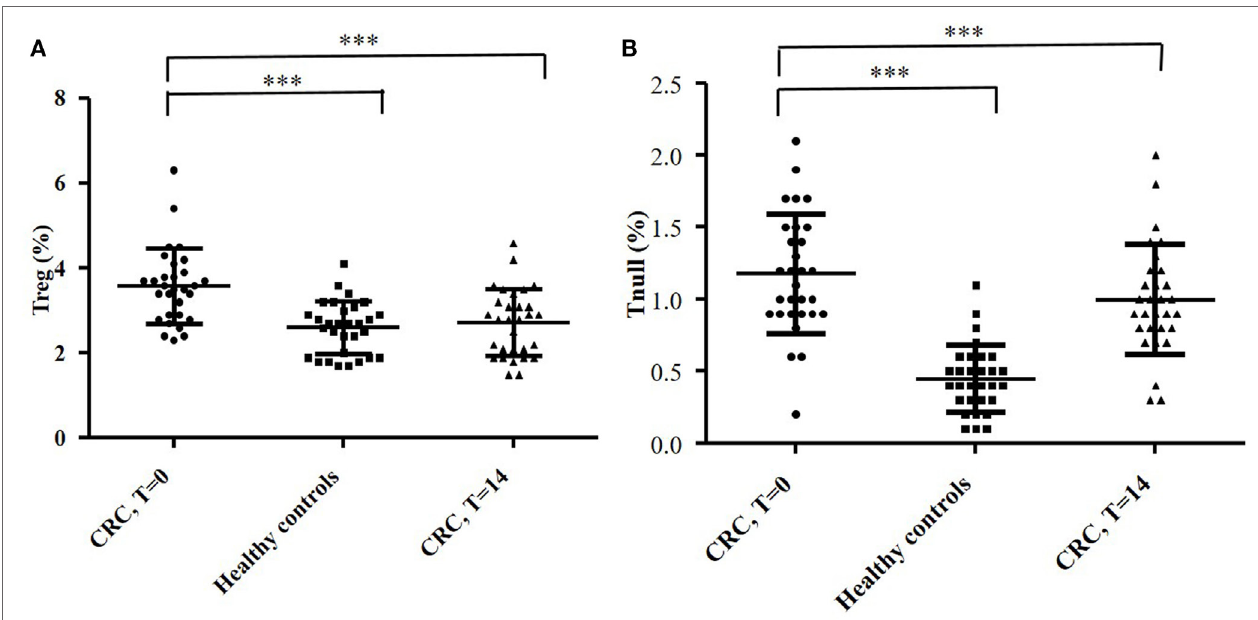
FigUre 8 | Evaluation of circulating CD4 + Treg (a) and Tnull (b) cells in blood samples of 30 colorectal cancer (CRC) patients and 30 healthy subjects. The evaluation of the T cells’ subsets was performed by flow cytometry (basing on the expression of specific markers) and at different time points: the day of the surgery ( T = 0) and 2 weeks after ( T = 14). The error bars represent the SD. Statistical analyses were calculated using one-way ANOVA and Turkey’s post hoc . The asterisks (*) represent p -values, * p < 0.05, ** p < 0.01, *** p <